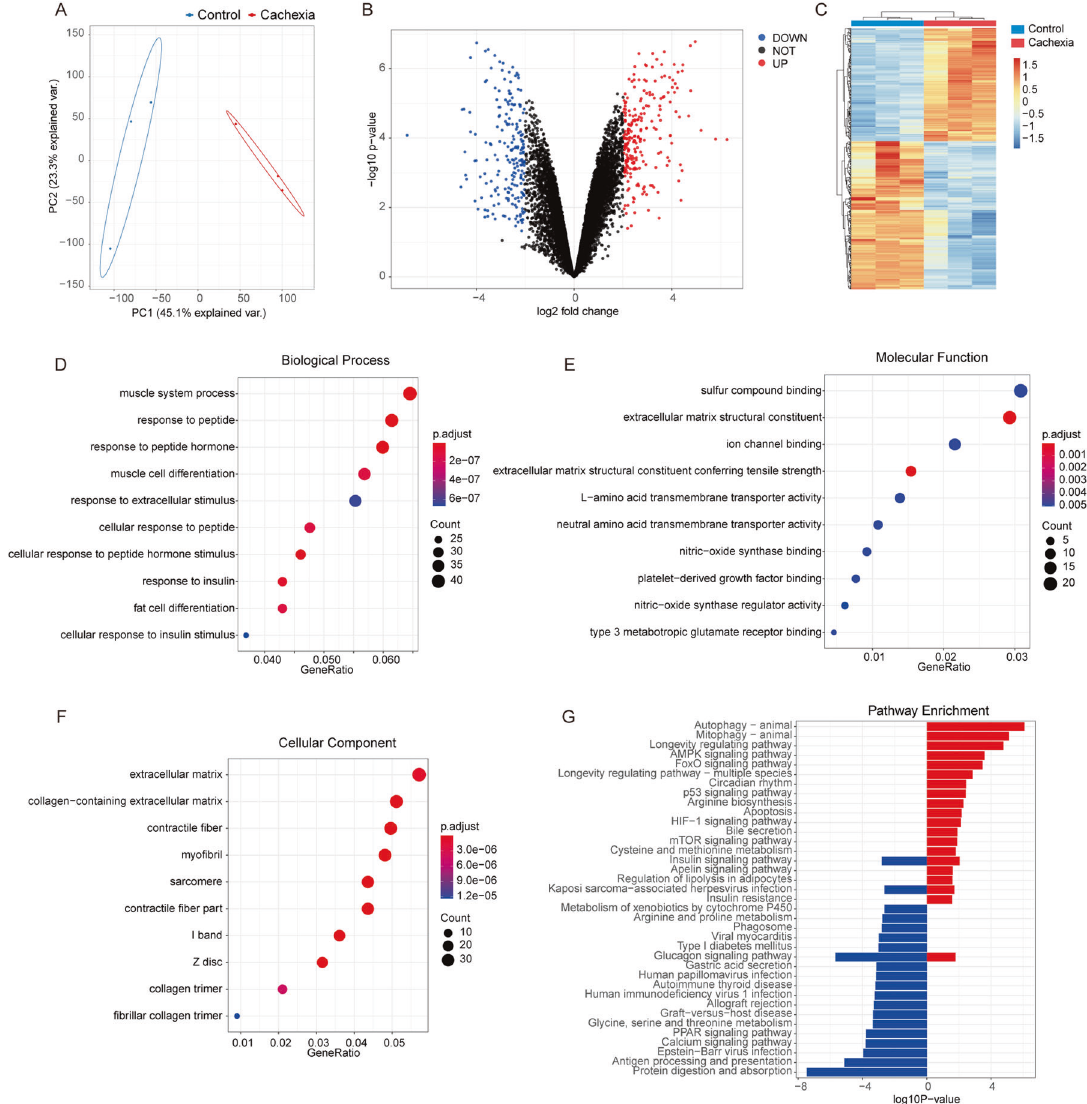
Fig. 2 RNA sequencing effectively discriminates between cachectic and noncachectic mice. A Principal component analysis (PCA) of the transcriptome of the muscles of C26-xenografted and control mice. B Volcano plots of differentially expressed genes (DEGs) of atrophied muscles with normal ones. Red dots represent upregulated DEGs (192), and blue dots represent downregulated DEGs (254). C Hierarchical clustering heatmap of the pro fi le of total DEGs between atrophied muscles and normal muscles. D – F . Gene ontology (GO) enrichment analysis of DEGs in biological process ( D ) molecular function ( E ) and cellular component ( F ) categories. G KEGG pathway mapping of DEGs. Red indicates upregulated pathways, blue indicates downregulated